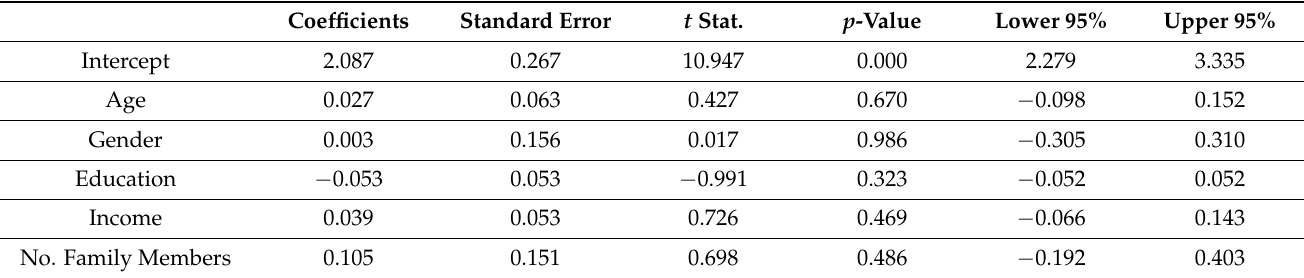
Table 7. Ordinal regression for negative